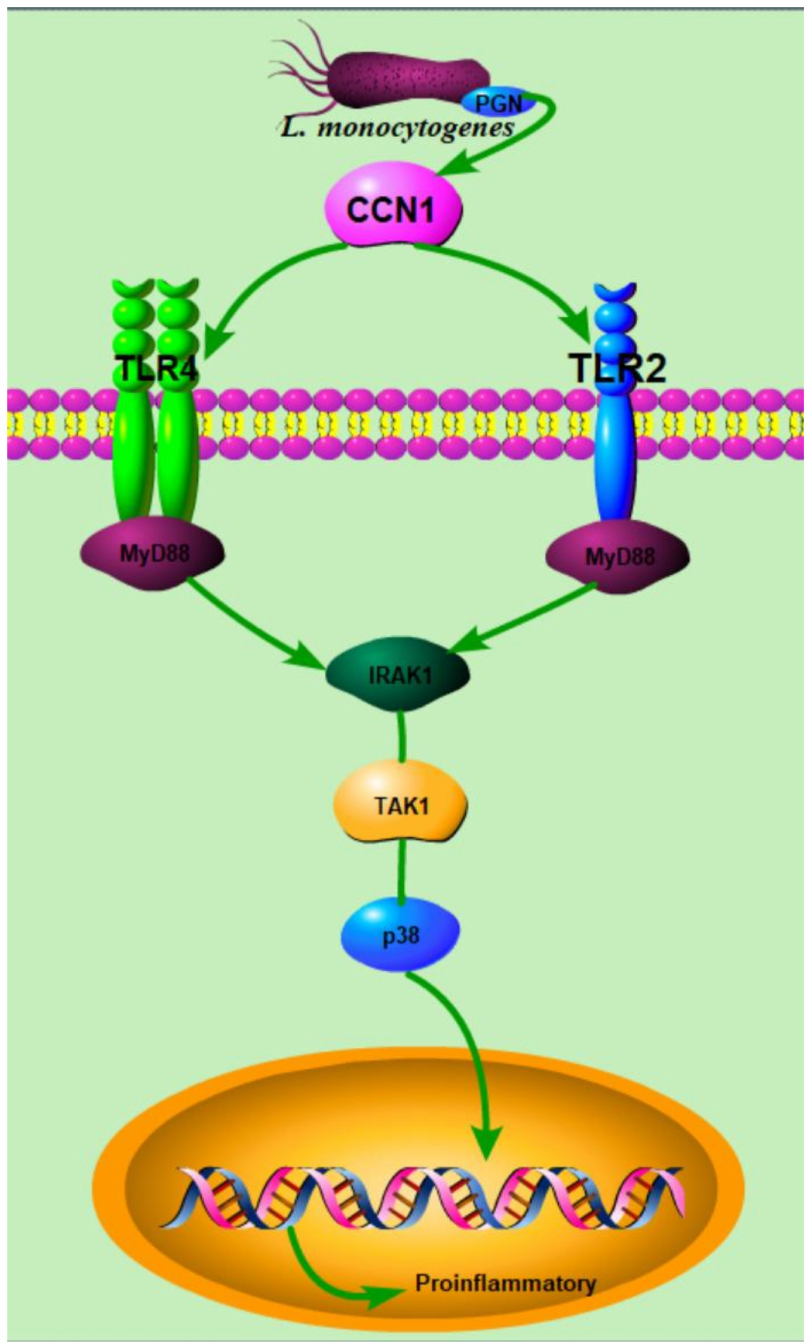
Figure 8. The conjectured mechanism of the intestinal epithelial cell’s response to L. monocytogenes